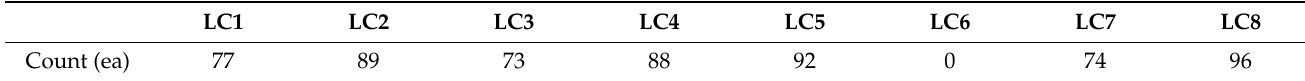
Table 3. The accuracy of the CNN model. Table 4. The number of almost laser cleaned